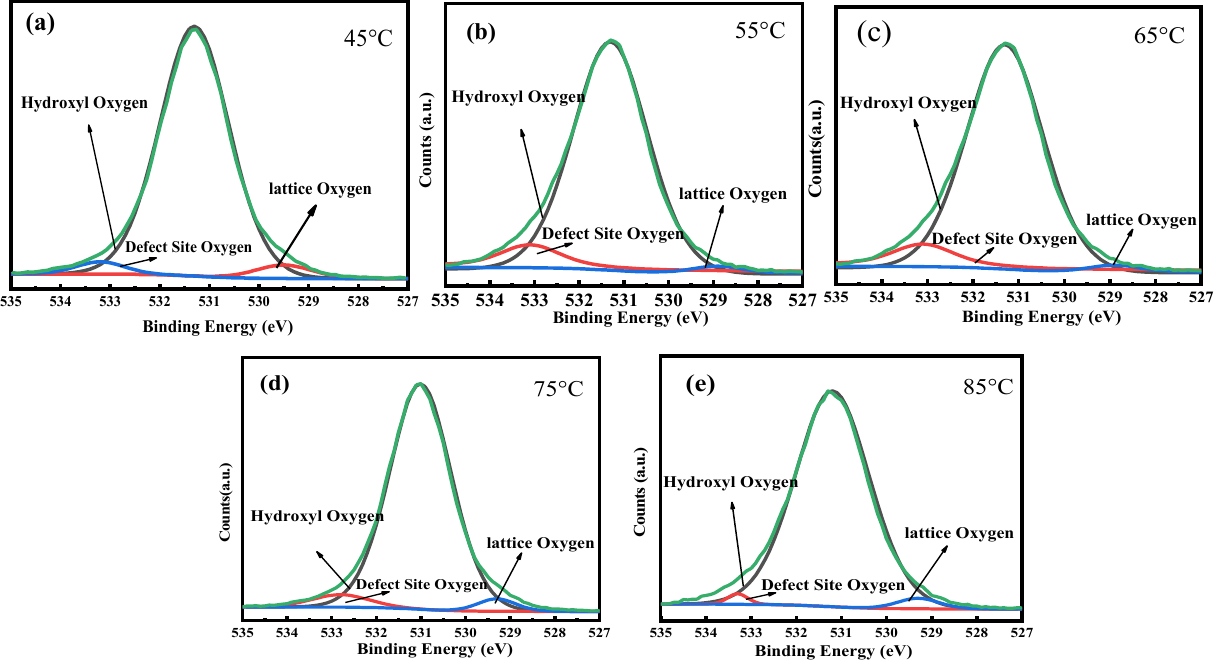
Table 2. Oxygen defect density of catalysts.